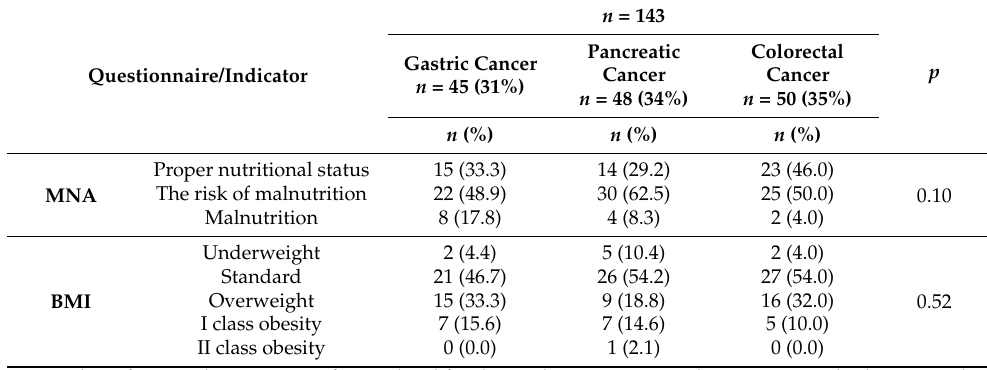
Table 1. Nutritional status of patients before surgery considering the location of the tumor.